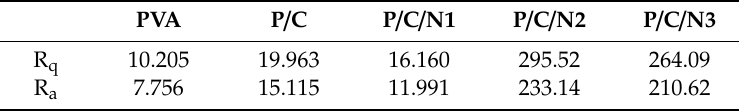
Figure 8. Representative atomic force microcopy (AFM) images of ( a ) PVA, ( b ) P/C, ( c ) P/C/N1, ( d ) P/C/N2, and ( e ) P/C/N3 composite films. Table 4. Roughness of the obtained composite